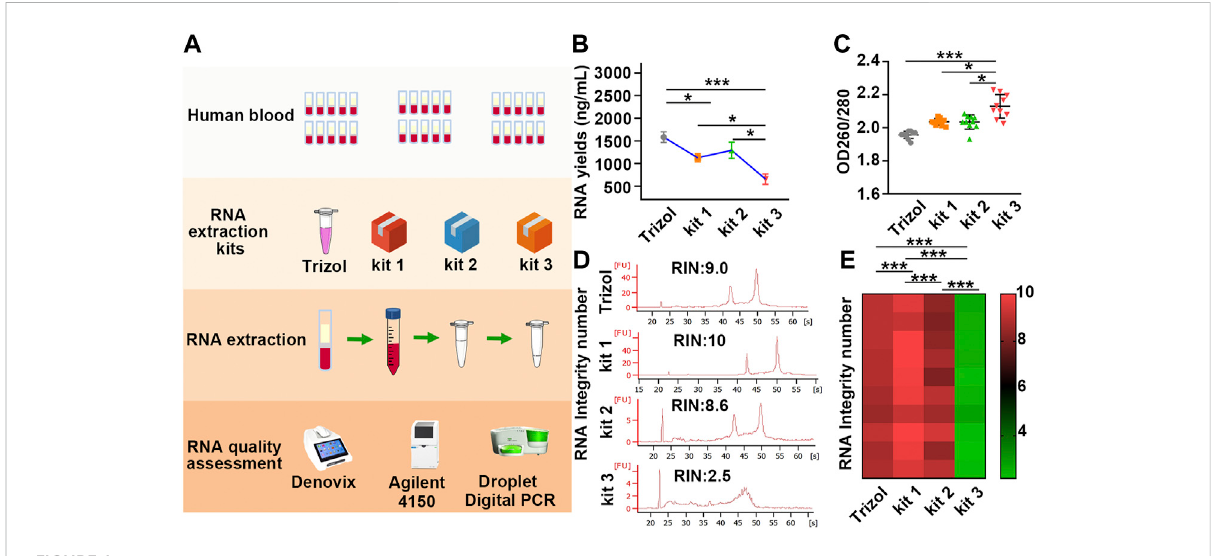
The yields, purity and RIN values of RNA extracted by different kits vary greatly. (A) Schematic illustration of the experimental schedule. (B) RNA yields in each group were assessed by Denovix. n = 40. (C) The 260/280 values were quanti fi ed using a DeNovix spectrophotometer. n = 40. (D) RepresentativeimageofRNAanalysisbyanAgilentbioanalyzerineachgroup.The fi rstpeakisa20 bpmolecularmarker.Thesecondandthirdpeaks are 18 sand 28 s rRNA. (E) A heatmap based on RIN values ineach sample.Red and green represent high and low RIN values, respectively. Data are represented as the mean ± SD ( n = 10). Tamhane ’ s T2 test (B,C) , LSD test (E) , * p < .05, ** p < .01, *** p <